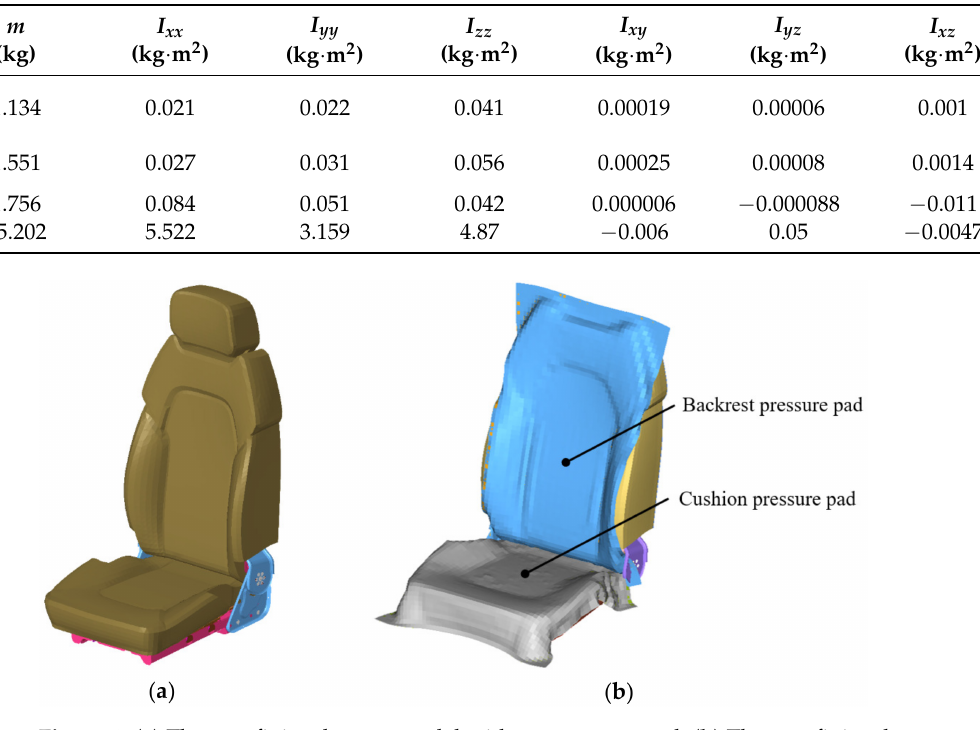
Table 1. Seat structure performance parameters.